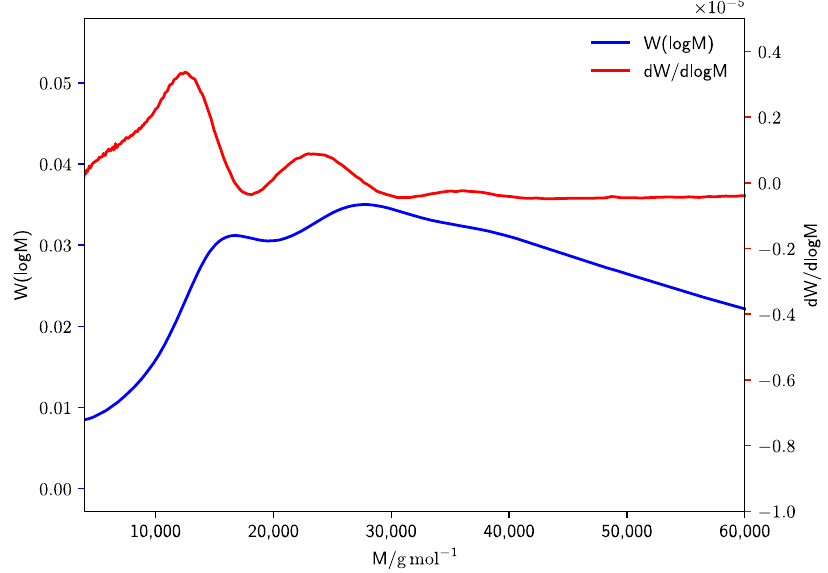
Figure 1. Detail of a representative molar mass distribution ( blue ) from PLP of DEI and its derivative ( red ). The molar masses L i were obtained from the maxima of the derivative curve.